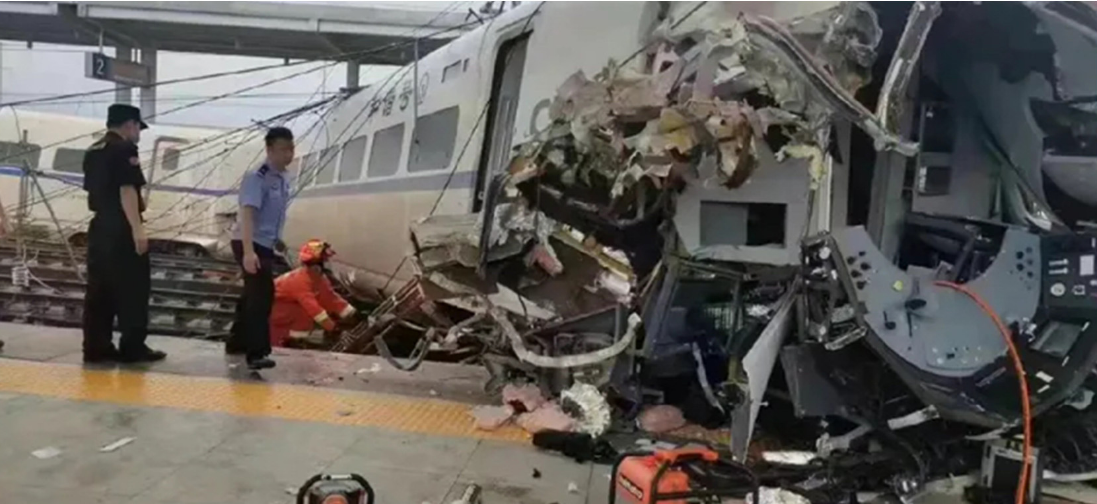
Figure 2. Accident scene (Source: https://www.163.com/dy/article/H9PN38TB0552ZFBN.html, accessed on 4 June 2022).